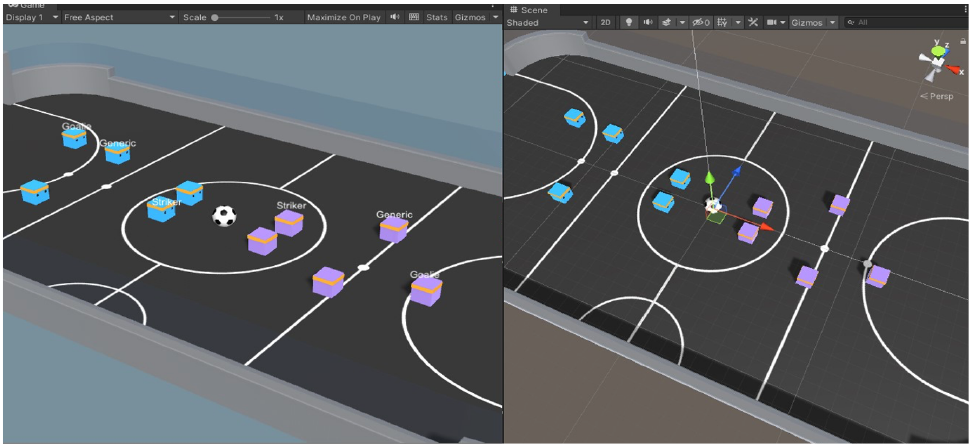
Figure 3. Screenshot of the proposed futsal game under design.